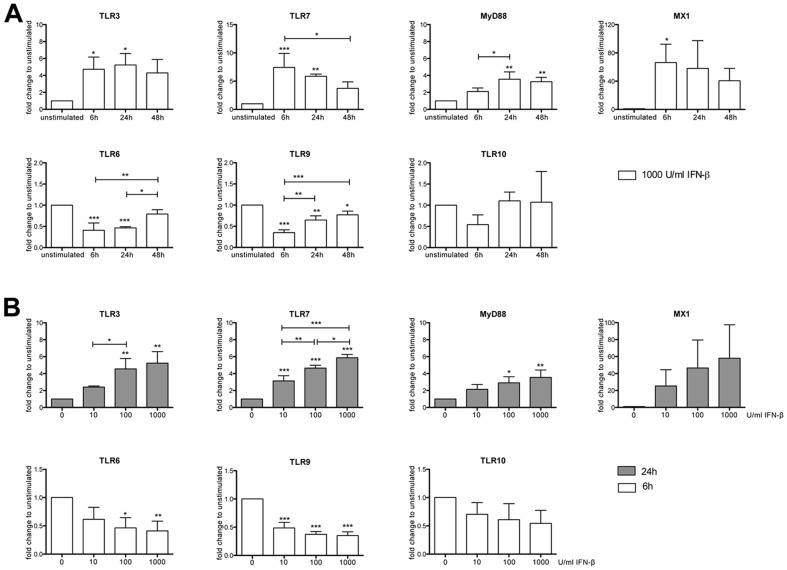
Dose- and time-dependent expression of TLR mRNA in PBMCs in response to interferon-β.(A) PBMCs from healthy donors were incubated with 1000 U/ml interferon-β. Control cells were left untreated. After 6, 24, and 48 hours RNA was isolated and qRT-PCR performed with primers for the indicated genes. (B) PBMCs were stimulated with 0, 10, 100, or 1000 U/ml interferon-β. After 6 hours (TLR6, TLR9, TLR10) or 24 hours (TLR3, TLR7, MyD88, MX1) RNA was isolated and qRT-PCR analysis performed. Results (mean±SD) from n = 3 independent experiments with PBMCs from different healthy donors are shown as fold-change to unstimulated controls. Statistical significance was assessed by one-way ANOVA with Tukey's post test. IFN-β, interferon-β; *p<0.05; **p<0.01; ***p<0.001.